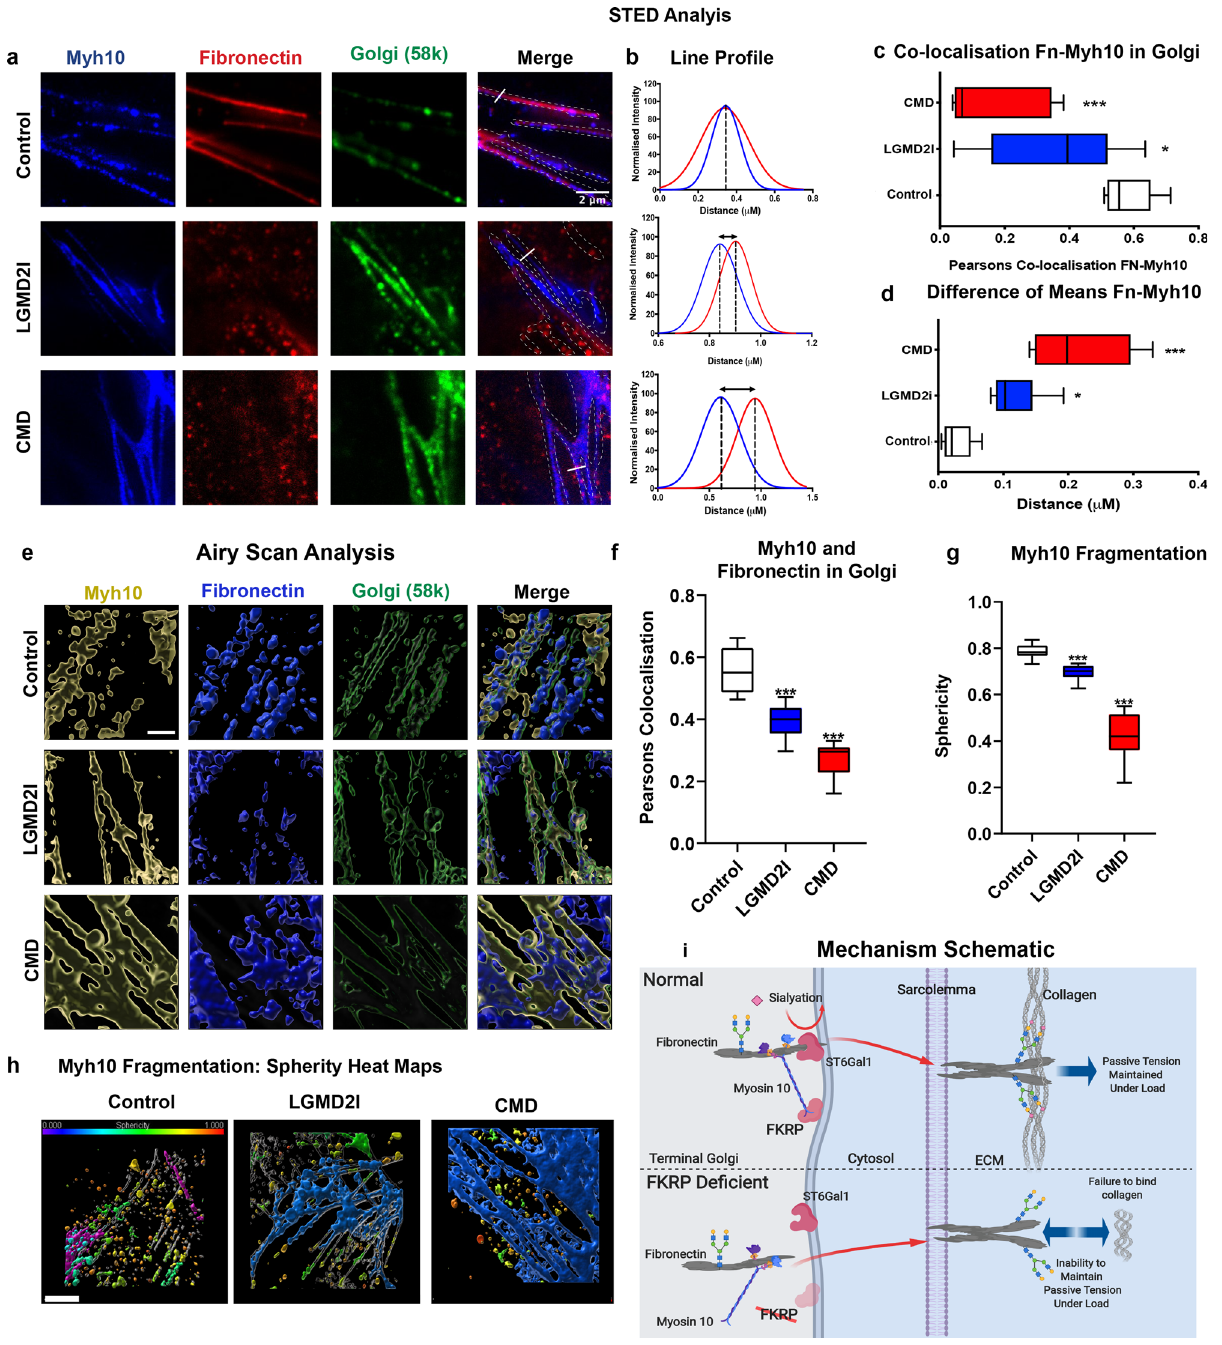
loss of FKRP function disrupts the localisation and tethering of fi bronectin to Myosin-10 within the Golgi, a process critical for fi bronectin maturation and sialylation, which in turn is required for collagen – fi bronectin binding. In line with a possible role for myosin10 in fi bronectin maturation, previous studies on myosin10 mutant mice have detected collagen deposition de fi cits in alveolar interstitial ECM 30 – 32 . Interestingly, the interstitial alveolar ECM in the lung is required for maintaining its elastic properties in a manner analogous to the